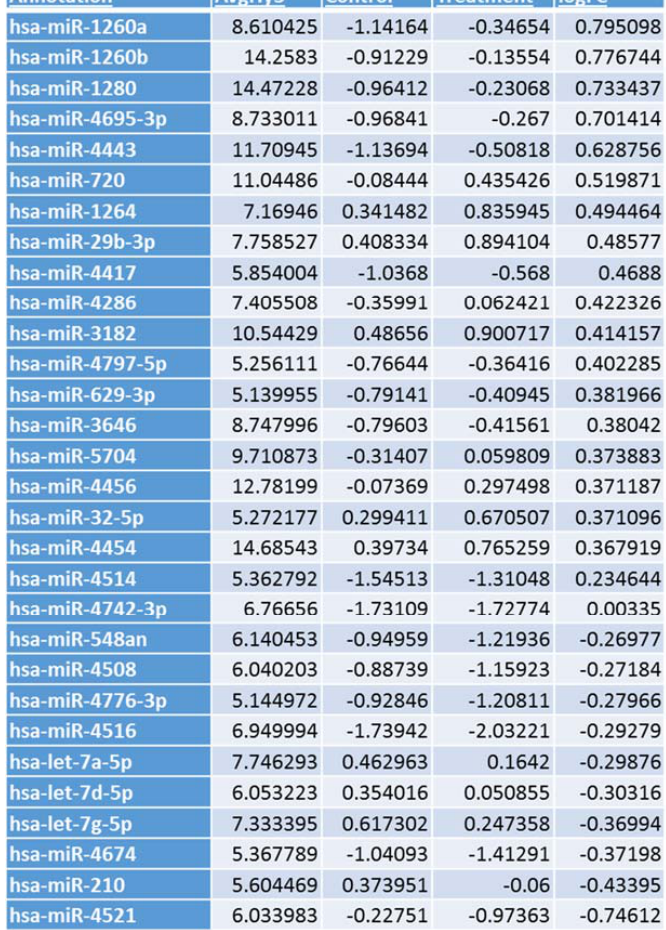
Figure 1. Influenza A virus (IAV) infection induced differential expression of microRNAs (miRNAs). Microarray analysis for miRNA expression was performed with RNA extracted from IAV infected A549 cells for 3 h. The log fold changes in expression of miRNAs that are up or downregulated on exposure to IAV are shown from the microarray. AvgHy3 ‐ Average signal intensity, logFC—log fold change, Control ‐ Mock; Treatment ‐ Infected with H1N1.